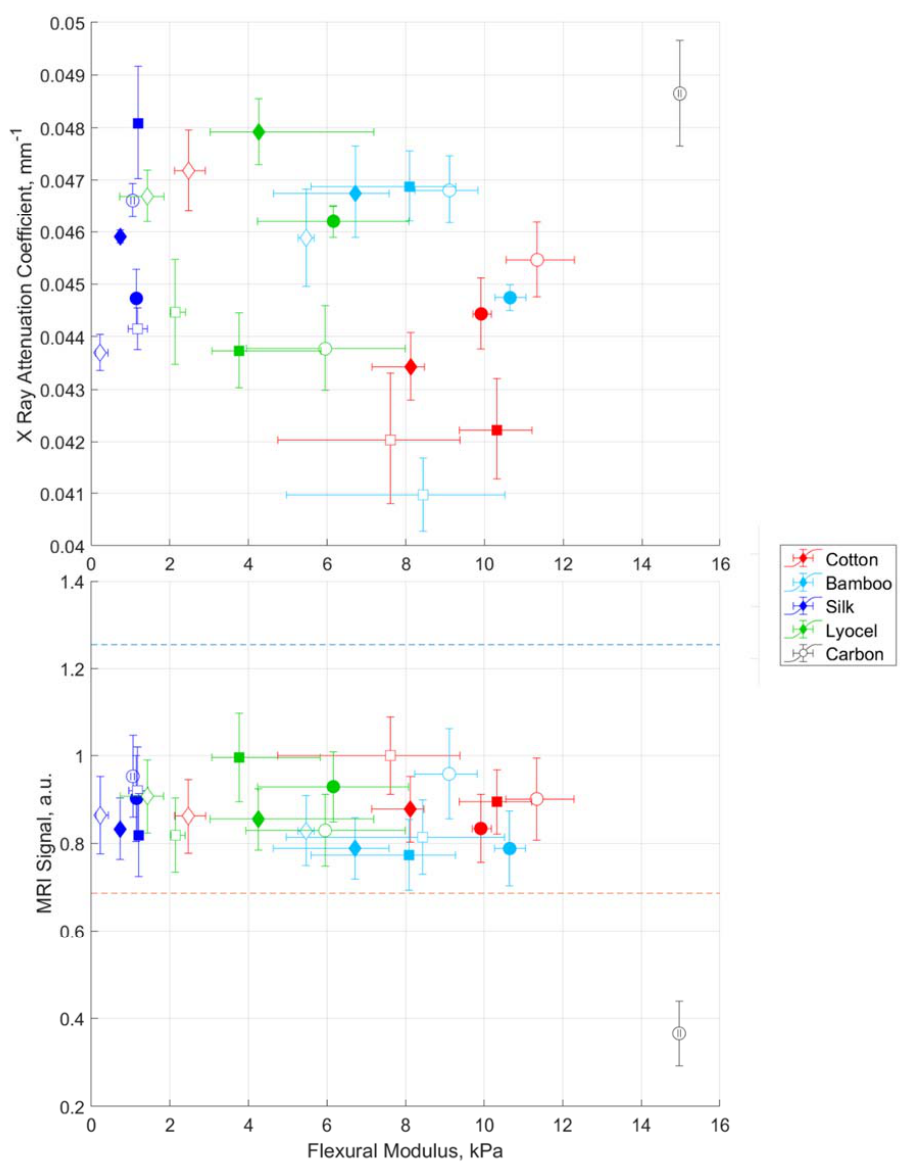
Figure 4. Overview of performance for X-ray (top) and magnetic resonance imaging (MRI) (bottom) as a function of flexural modulus. The optimum position for X-Ray is bottom right, the optimum position for MRI is top right. Colours represent different fibres as detailed in the legend. The shapes represent different resins as follows: circles (O) epoxy, squares ( □ ) synthetic UV, diamond ( ◇ ) soy UV. Finally, untreated are open and treated are filled.